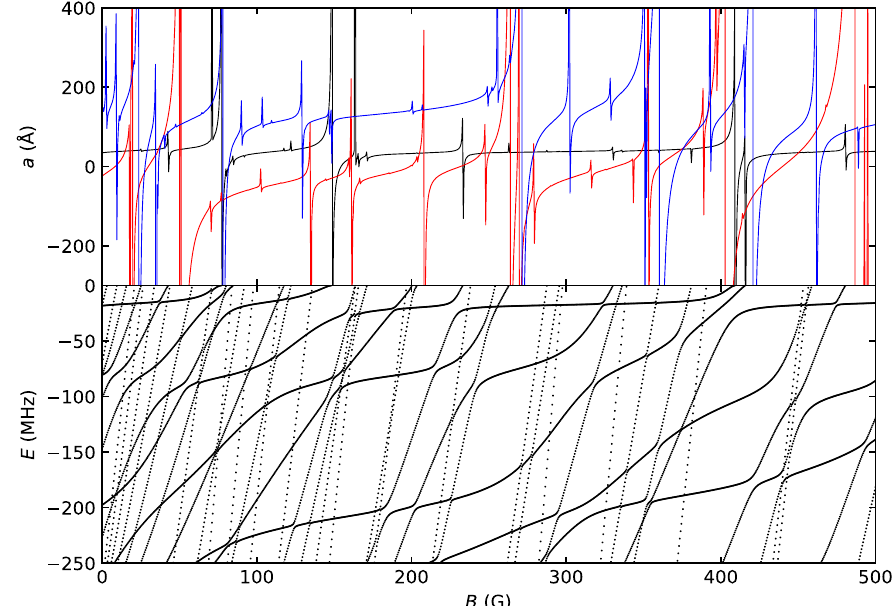
2 Þ ð 0 Þ 0 . 017 for three 6 =C 6 ¼